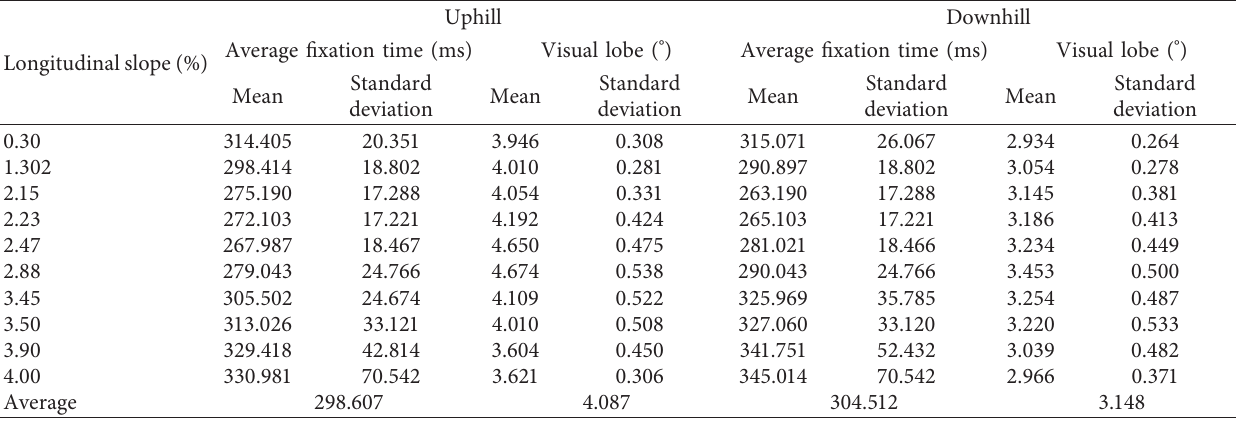
Figure 1: The eye tracker (a) and vehicle (b). Table 3: The mean value of the average fixation time and visual lobe under different longitudinal slopes of the uphill and downhill sections.